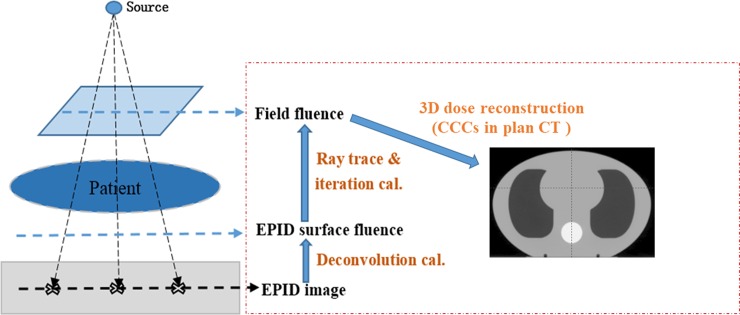
Schematic diagram of EPID-based 3D in vivo dose reconstruction.